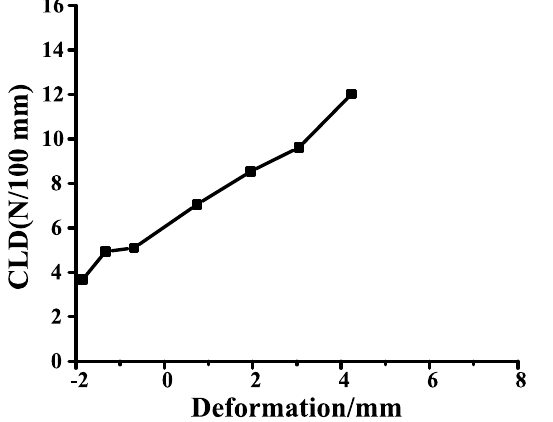
Figure 4. Section characteristics of inner belt. The Y axis represents CLD, the X axis represents deformation, and 0 mm is the standard used.